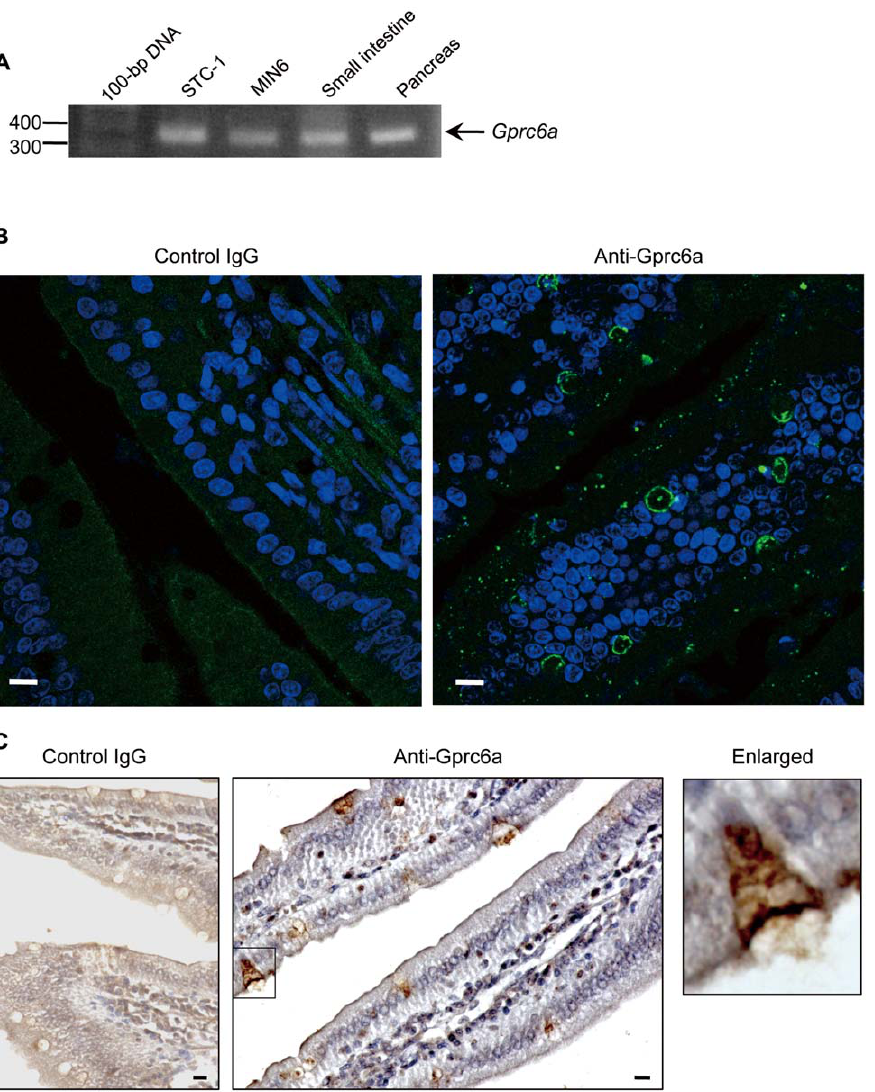
Figure 1. Expression of Gprc6a in mouse small intestine. ( A ) Semiquantitative RT-PCR analysis of Gprc6a mRNA in STC-1 and MIN6 cells as well as in mouse small intestine and pancreas. ( B ) Immunofluorescence analysis of Gprc6a expression (green) in mouse ileum. Rabbit c -globulin was used as a negative control, and nuclei were stained with Hoechst 33342 (blue). ( C ) Gprc6a immunostaining by ABC techniques (brown), counterstained with hematoxylin. A higher magnificent image of cell indicated by a rectangle is shown in the right. Bars, 10 m m.